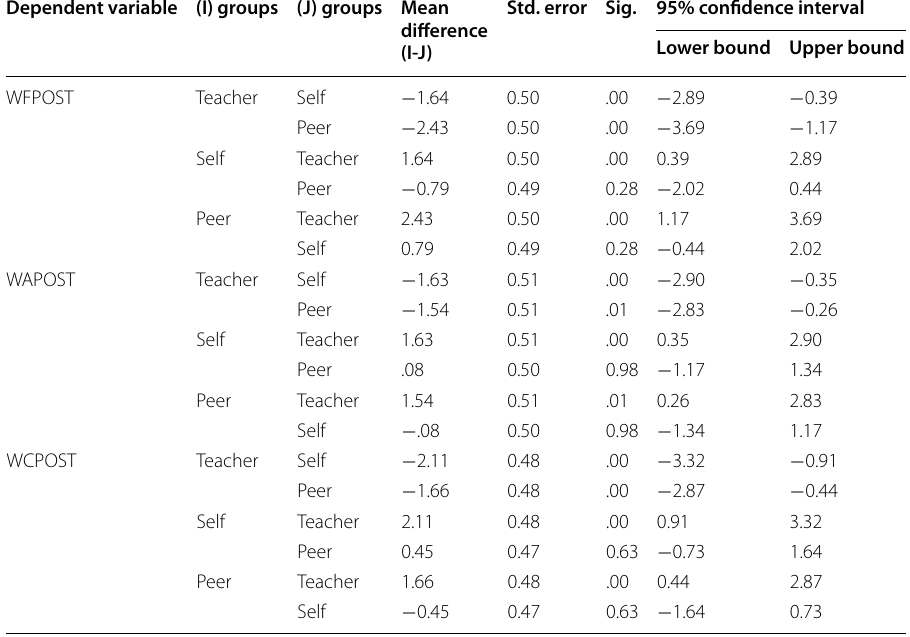
Table 10 Post hoc Scheffe test (all groups’ posttests of writing accuracy, fluency, and complexity) Dependent variable (I) groups (J) groups Mean difference